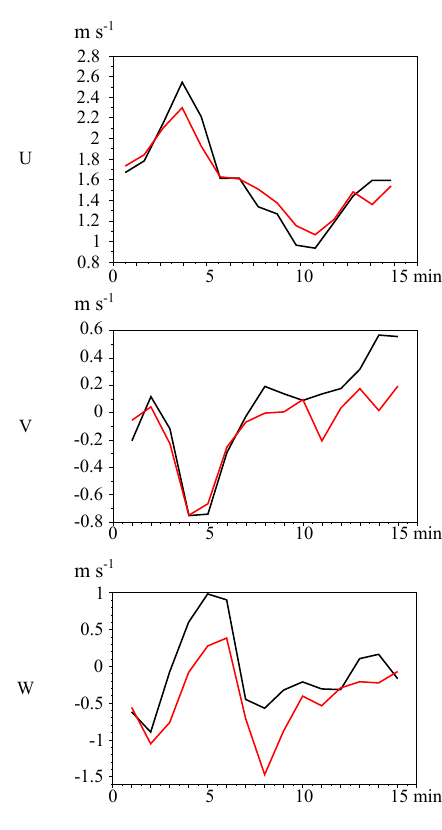
Figure 5. Time evolution of the three wind components obtained from the coarse Meso-NH simulation (black) and by the particle model (red) for one cell of the coarse